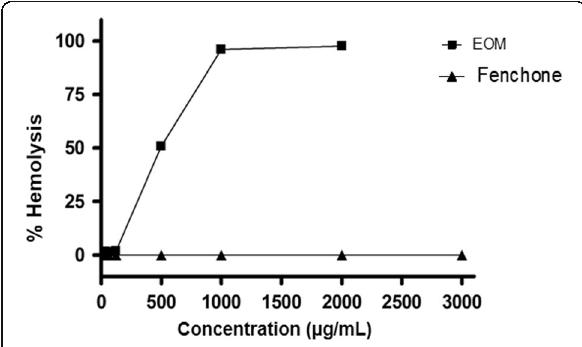
Fig. 1 Hemolysis percentage in red blood cells of Swiss mice after treatment with EOM ( μ g/mL). Each dot represents the average ± SEM of three experiments with three replicates, with 95% confidence